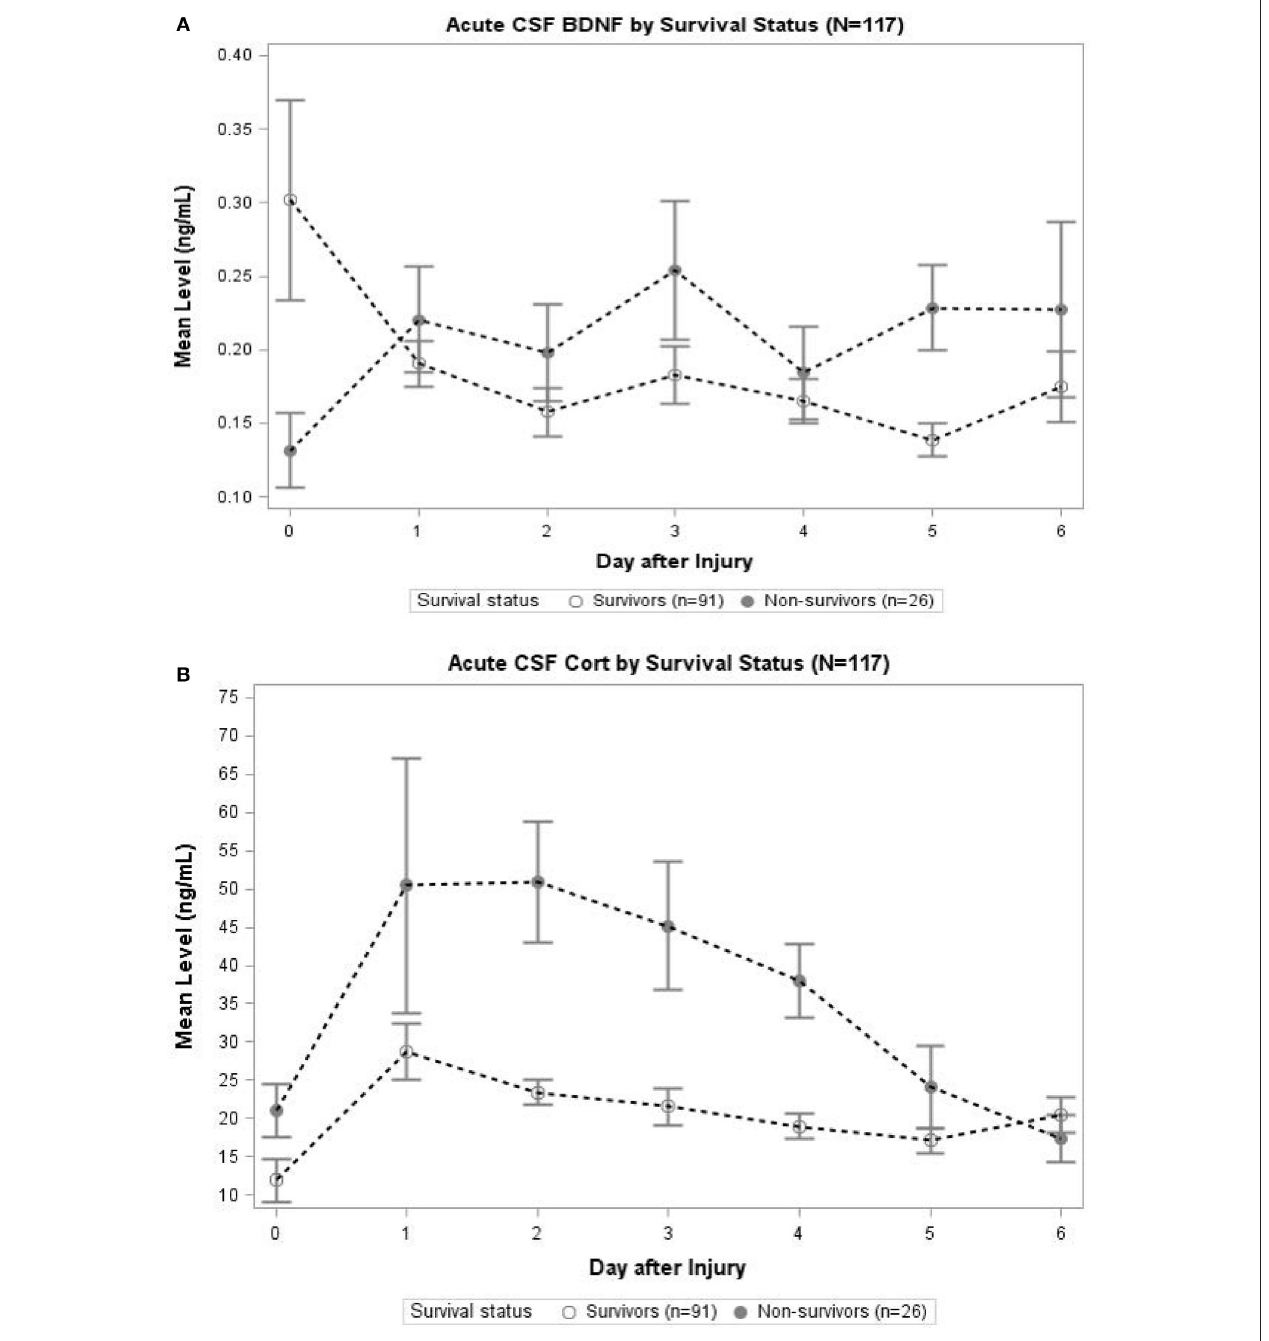
FIGURE 3 | (A) Acute CSF Cortisol by Survival Status ( N = 117). The open circles indicate survivors and closed circles are non-survivors. Data for CSF Cortisol (ng/mL) were averaged within survival category each day. Error bars indicate standard error of the mean. On days 2–4, CSF Cortisol levels were significantly ( p < 0.05) elevated among non-survivors compared to survivors. (B) Acute CSF BDNF by Survival Status ( N = 117). The open circles indicate survivors and closed circles are non-survivors. Data for CSF BDNF (ng/mL) were averaged within survival category each day. Error bars indicate standard error of the mean. On days 3 and 5, CSF BDNF levels were significantly ( p < 0.05) elevated among non-survivors compared to survivors. There was a trend toward significant difference in levels on day 0 ( p = 0.078); there were no significant differences in CSF BDNF levels for any other day. stress (Marmigère et al., 2003; McEwan, 2015). However, This initial increase in BDNF may represent a physiological response to influence HPA reactivity and attempt to maintain BDNF increases can be pathological in the setting of high homeostasis within the brain in response to initial/acute and/or prolonged pathophysiological stress (e.g., TBI). Clinically,